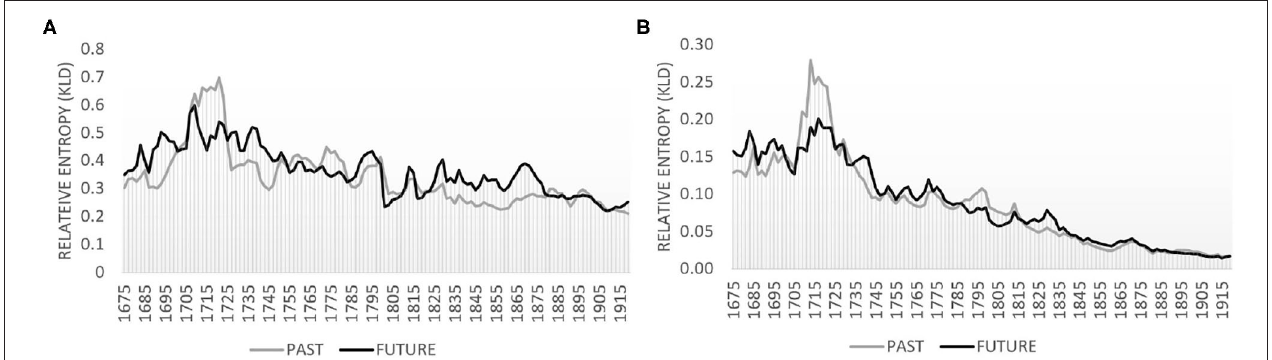
FIGURE 1 | Relative entropy based on lemmas and part-of-speech trigrams with 2-year slider and 10-year past and future periods. (A) Lemmas. (B) Part-of-speech trigrams.